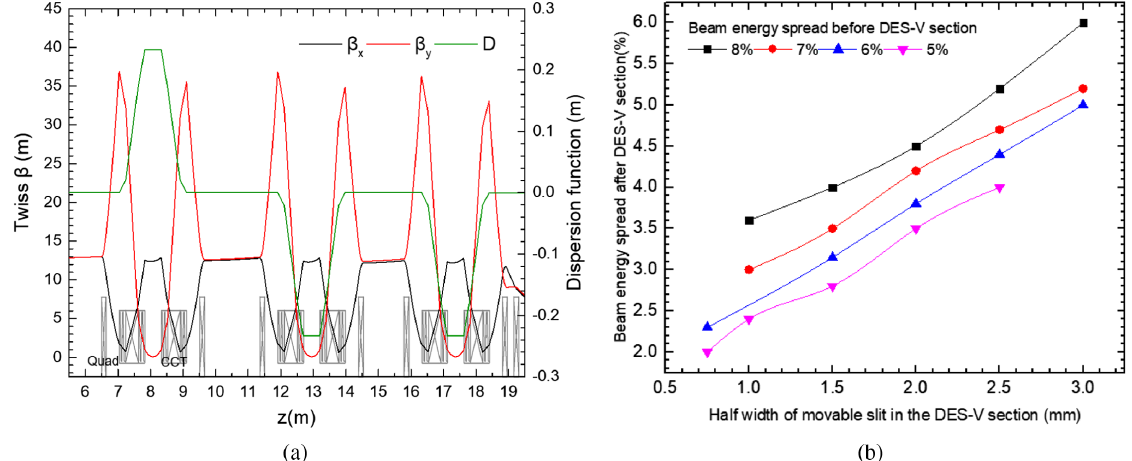
FIG. 4. Beam parameters in the DES-V section, showing (a) Twiss- β and dispersion function along the z axis; and (b) Final energy spread against slit width for different initial energy spreads.